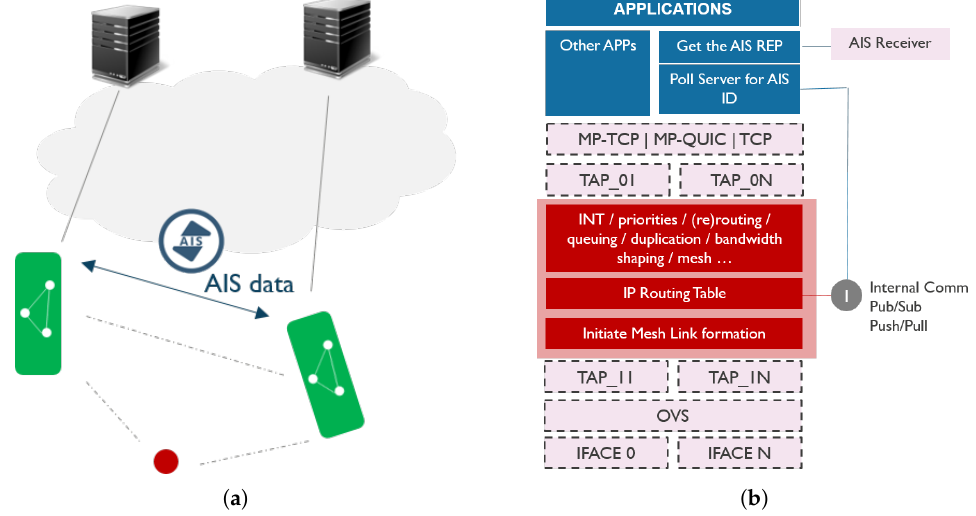
Figure 5. Hybrid discovery including ( a ) schematic representation of network topology and ( b ) communication stack design.